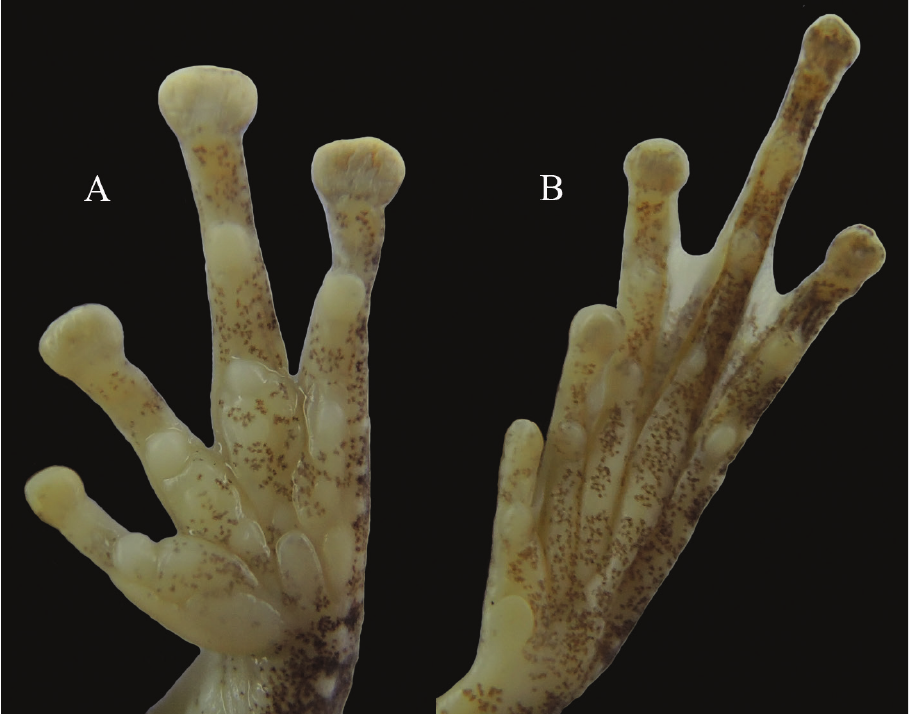
Figure 5. Ventral view of hand A and foot B of the holotype of Kurixalus lenquanensis sp. n. in